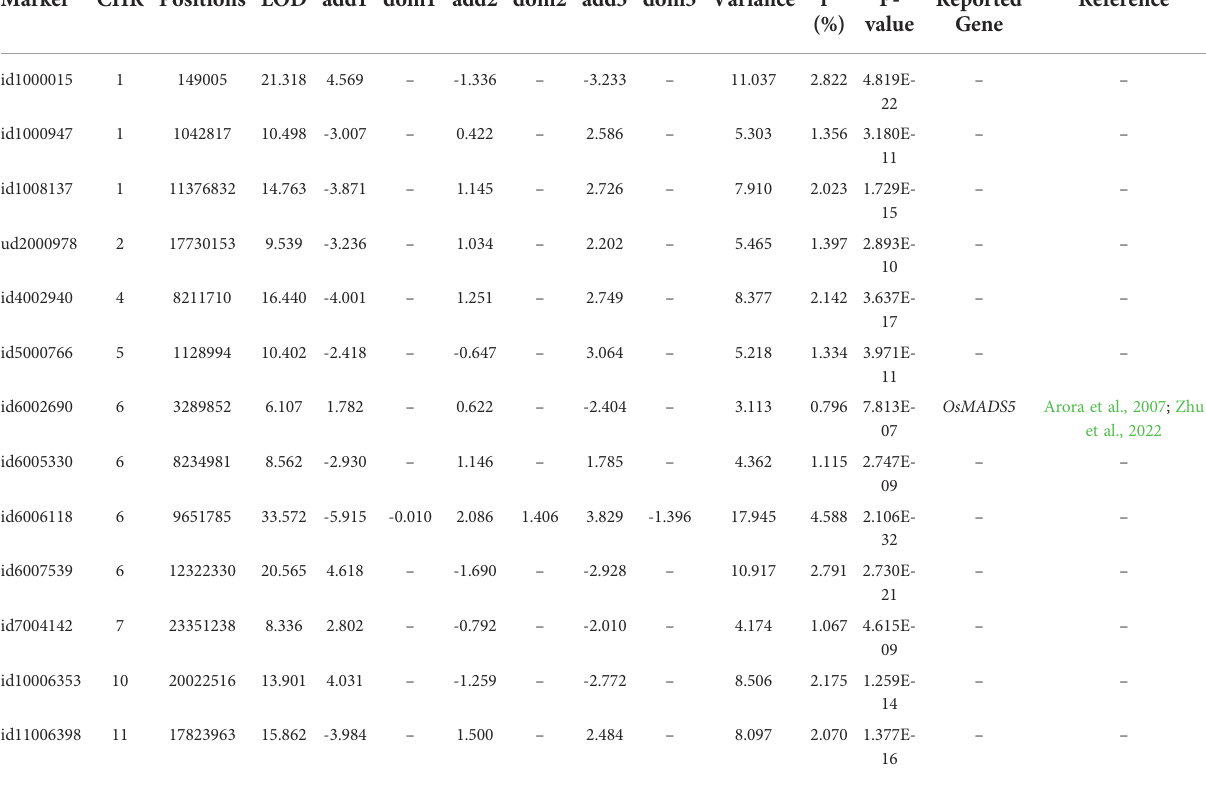
TABLE 4 Signi fi cant/suggested QEIs for rice fl owering time in three environments detected using the QTN-by-environment detection model in 3VmrMLM.